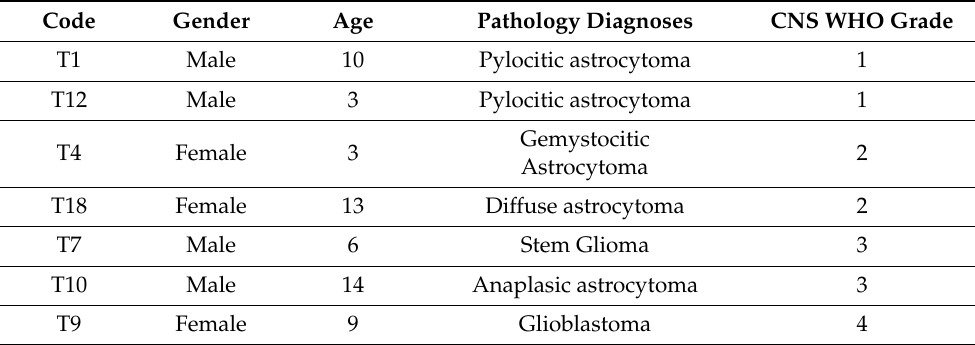
Table 3. Diagnostic characteristics of the brain glioma biopsies of pediatric